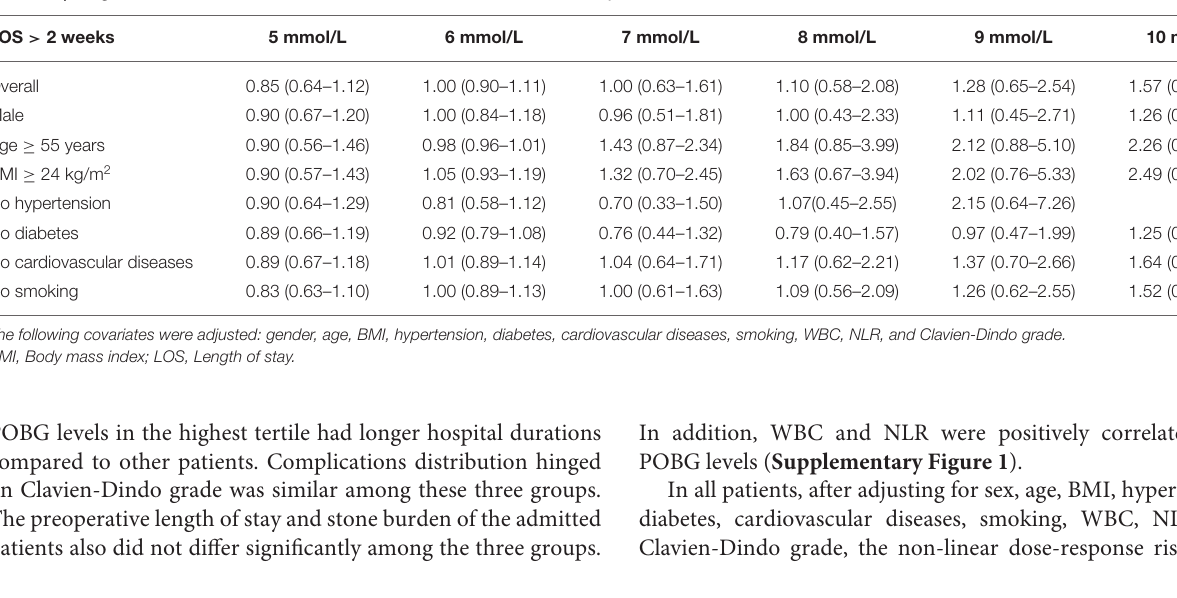
TABLE 2 | Weighted odds ratio and 95% confidence intervals of LOS > 2 weeks by levels of POBG